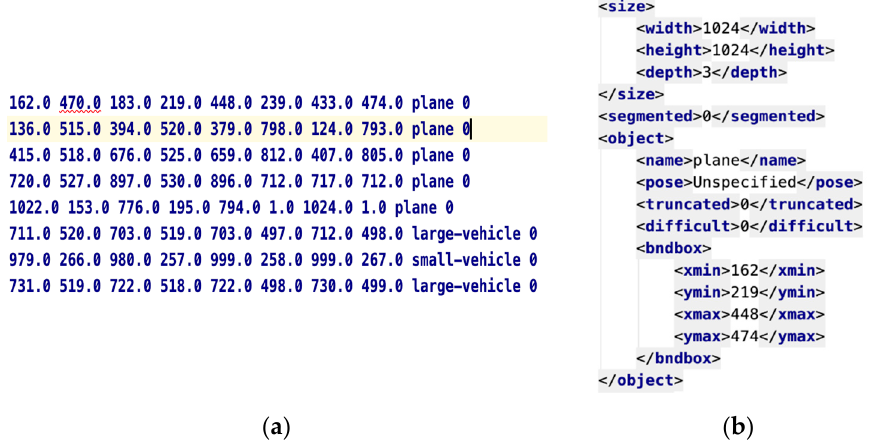
Figure 6. Annotation file. ( a ) DOTA (Dataset of Object Detection in Aerial Images) dataset; ( b ) the dataset used in this